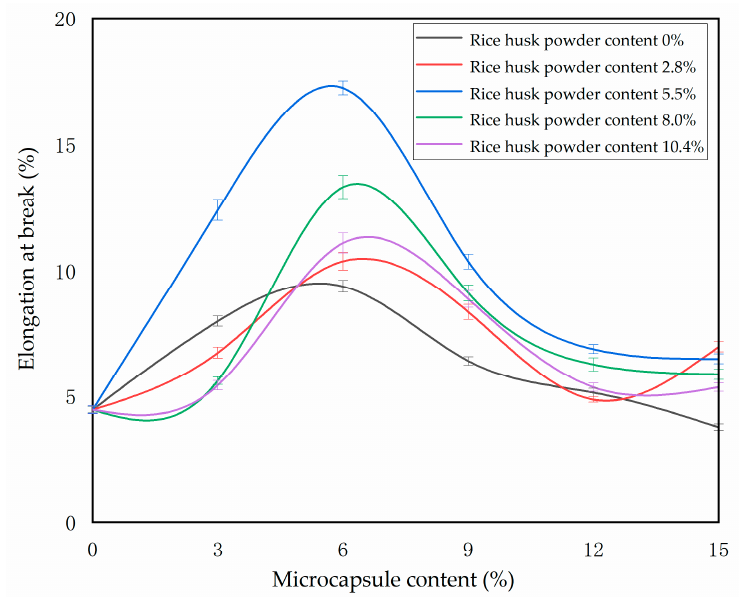
Figure 8. Effect of microcapsules with different contents of rice husk powder on elongation at break of waterborne primer coating.